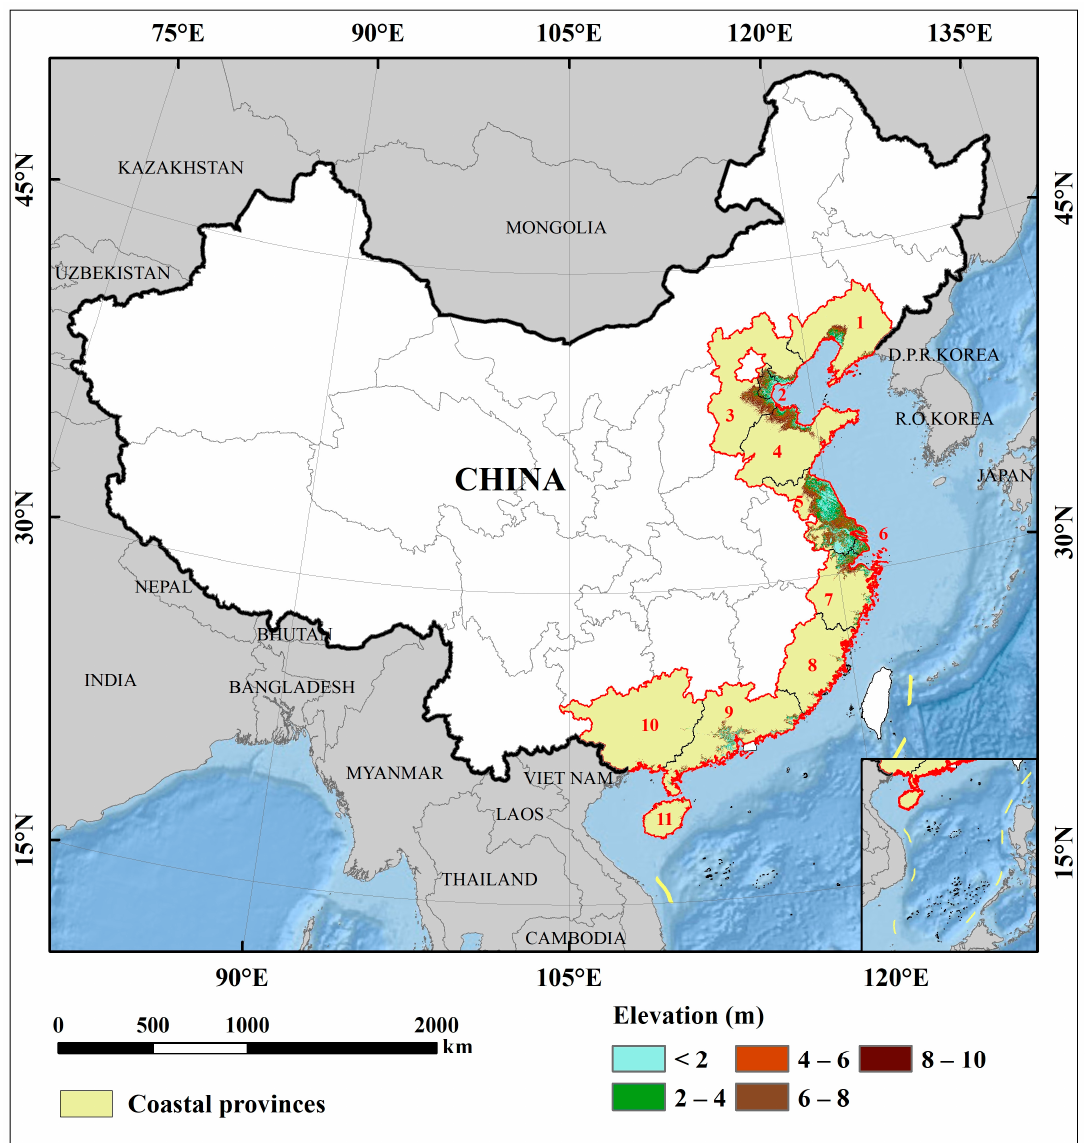
Figure 1. Coastal provinces and LECZ in China. Numbers 1–11 represent Liaoning, Tianjin, Shandong, Jiangsu, Shanghai, Zhejiang, Fujian, Guangdong, Guangxi and Hainan,